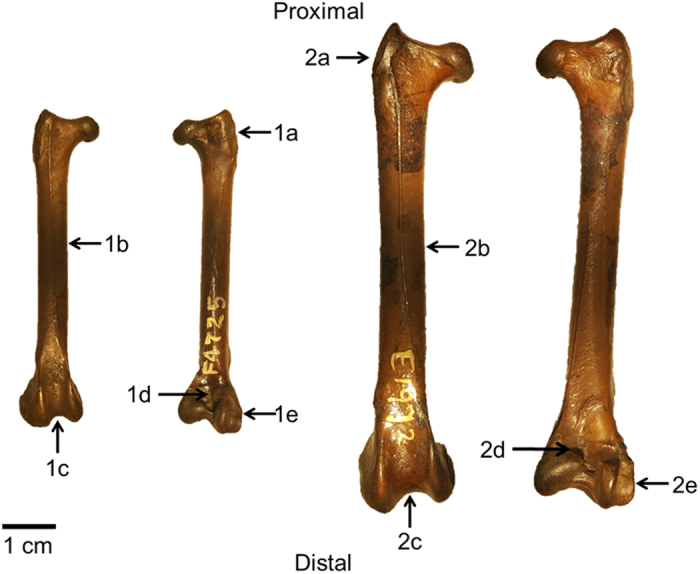
Tyto alba (1a–e) and Bubo virginianus (2a–e) femur morphology. Anterior view on left and posterior view on right for each specimen. (1a) Moderately developed, strong trochanter; (1b) Straight shaft; (1c) Deep, wide rotular groove; (1d) Shallow popliteal area; (1e) Strongly developed fibular condyle. (2a) Stout trochanter with heavily sculptured base; (2b) Stout, straight shaft; (2c) Wide, deep rotular groove; (2d) Deep popliteal area; (2e) Prominent fibular condyle.